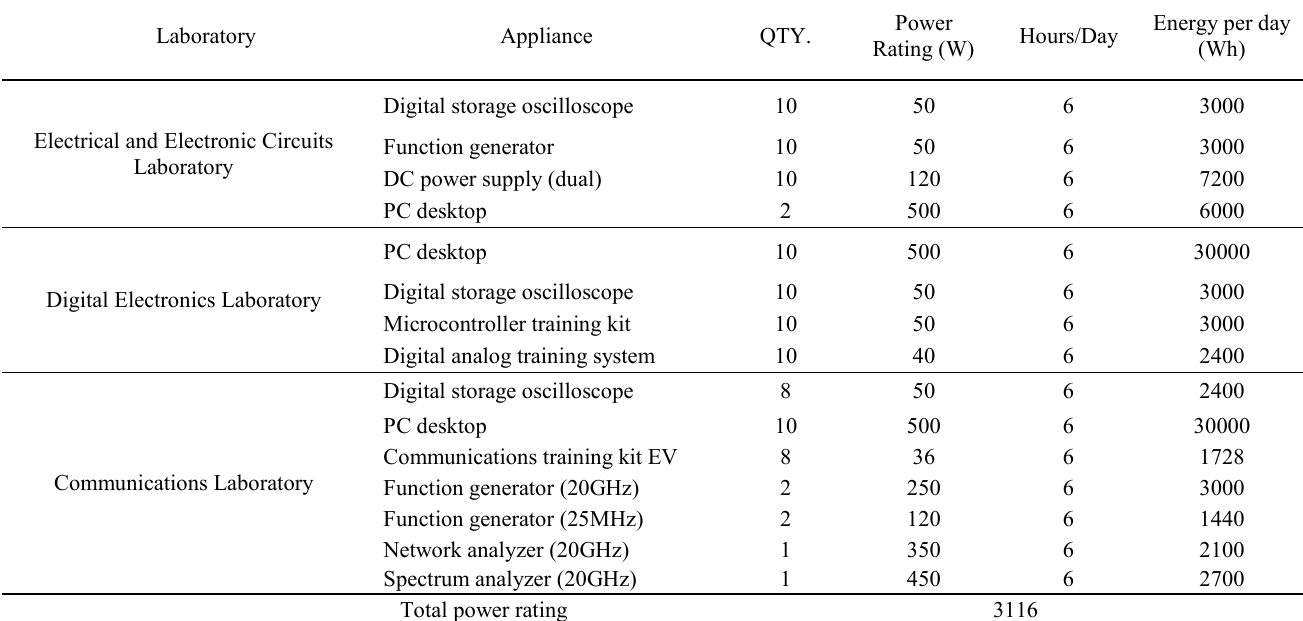
Table 4. Total energy requirement and power rating of the